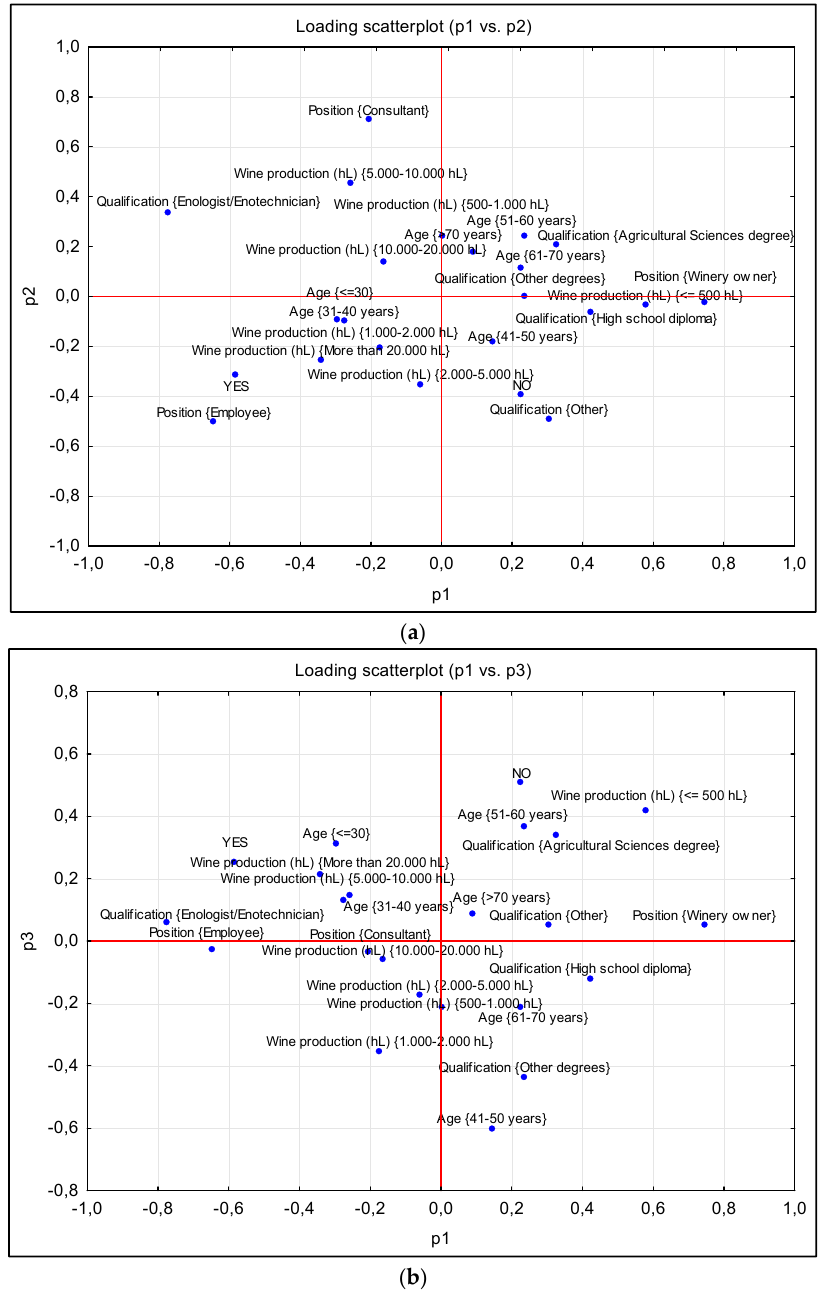
Figure 3. Loading scatterplot ( a ) P1 vs. P2 and ( b ) P1 vs. P3.